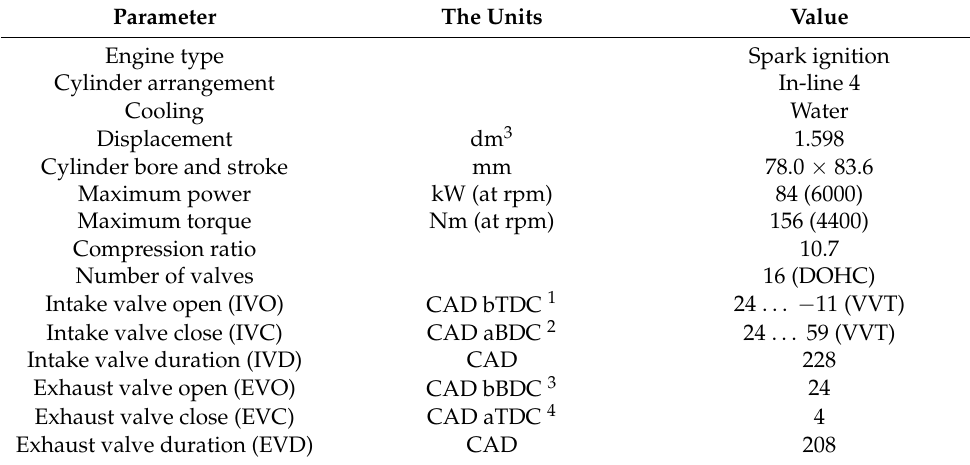
Table 1. Technical characteristics of engine